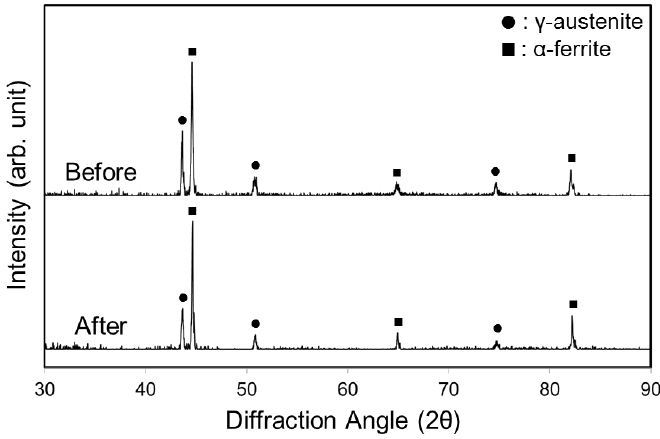
Figure 4. XRD patterns of the powders before and after treatment using RF plasma. Table 2. Results of the ICP-AES analysis of the powders before and after treatment using RF plasma. Composition (wt. Elements